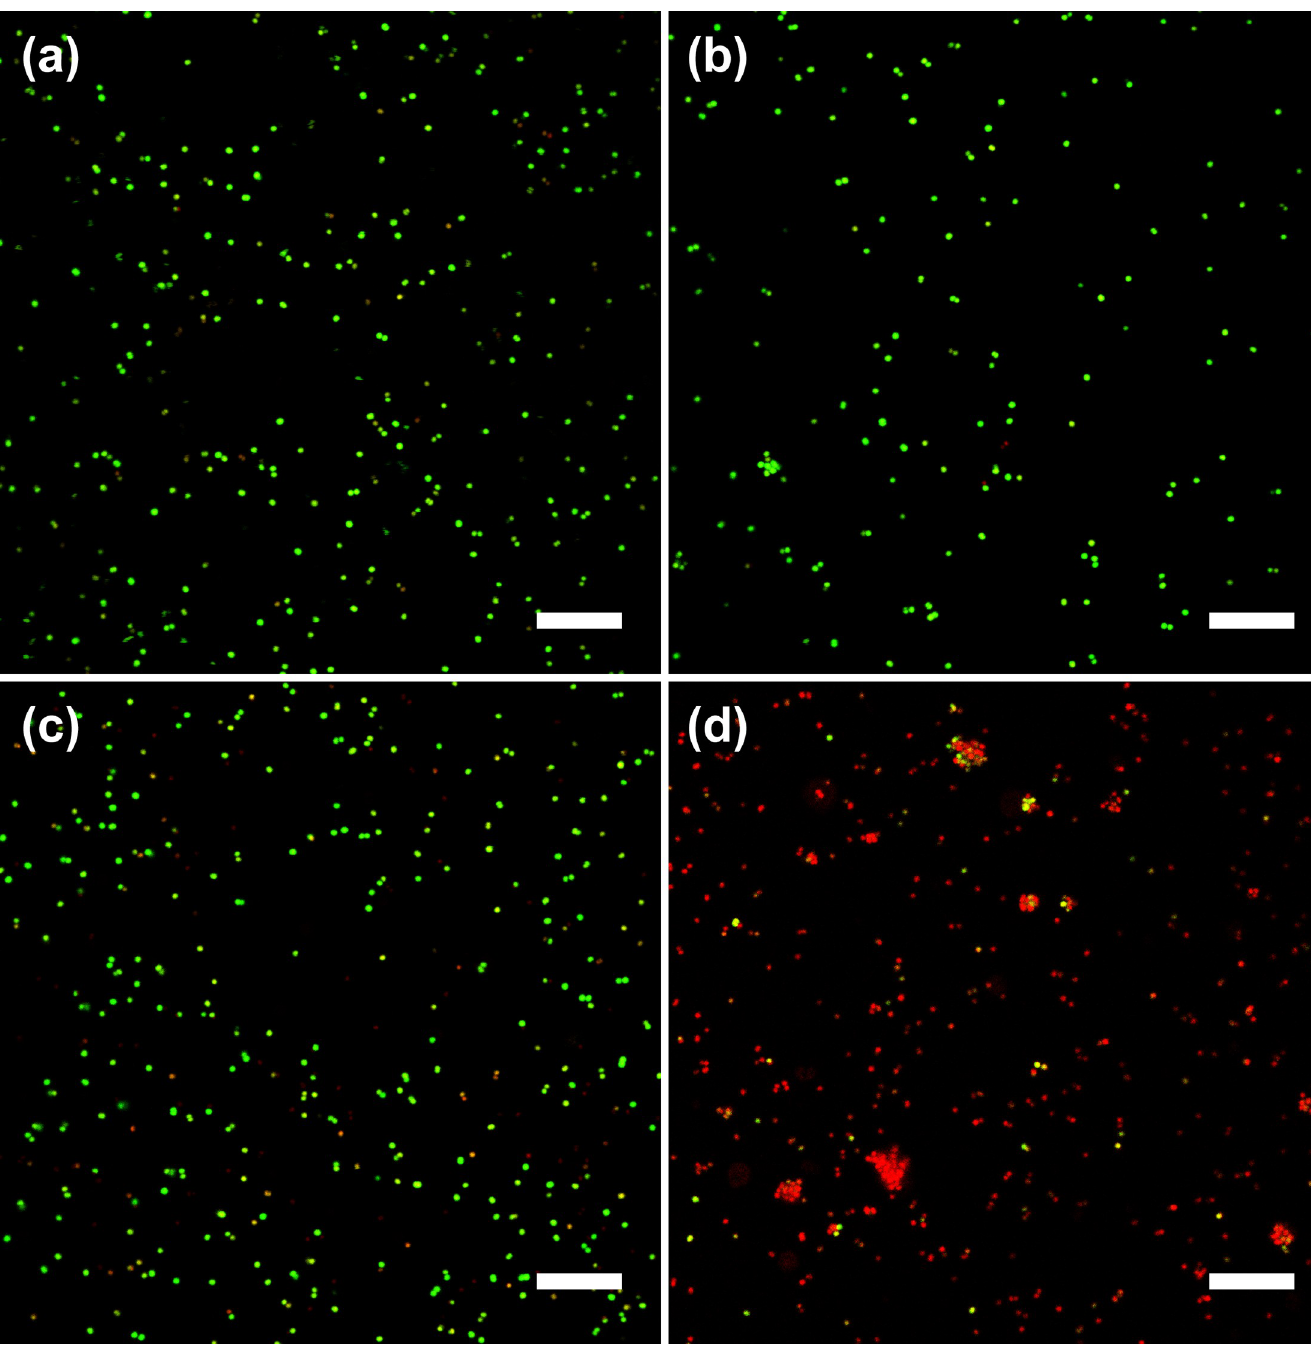
PLOS ONE | https://doi.org/10.1371/journal.pone.0224816 November15,